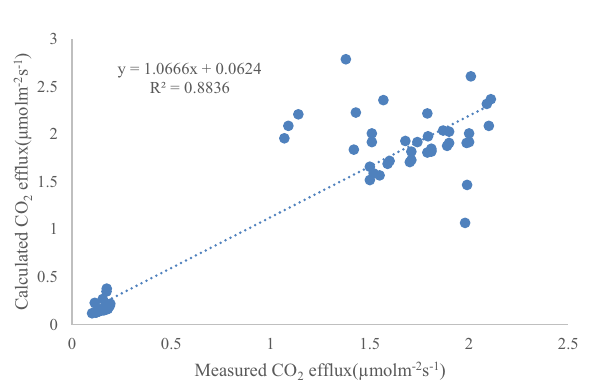
y = 1.0666x + 0.0624 R² = 0.8836